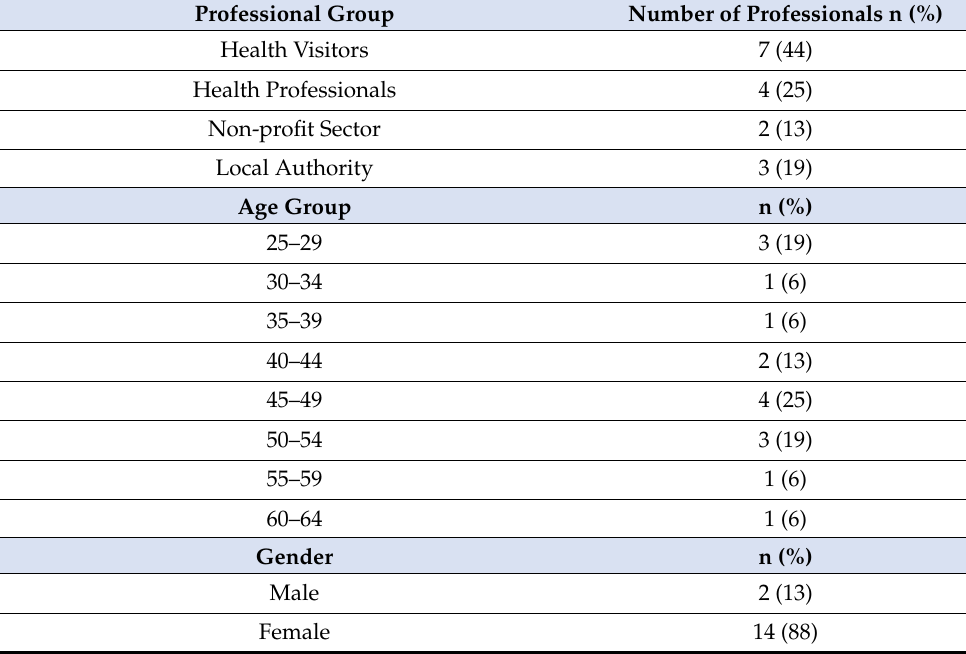
Table 1. Professional